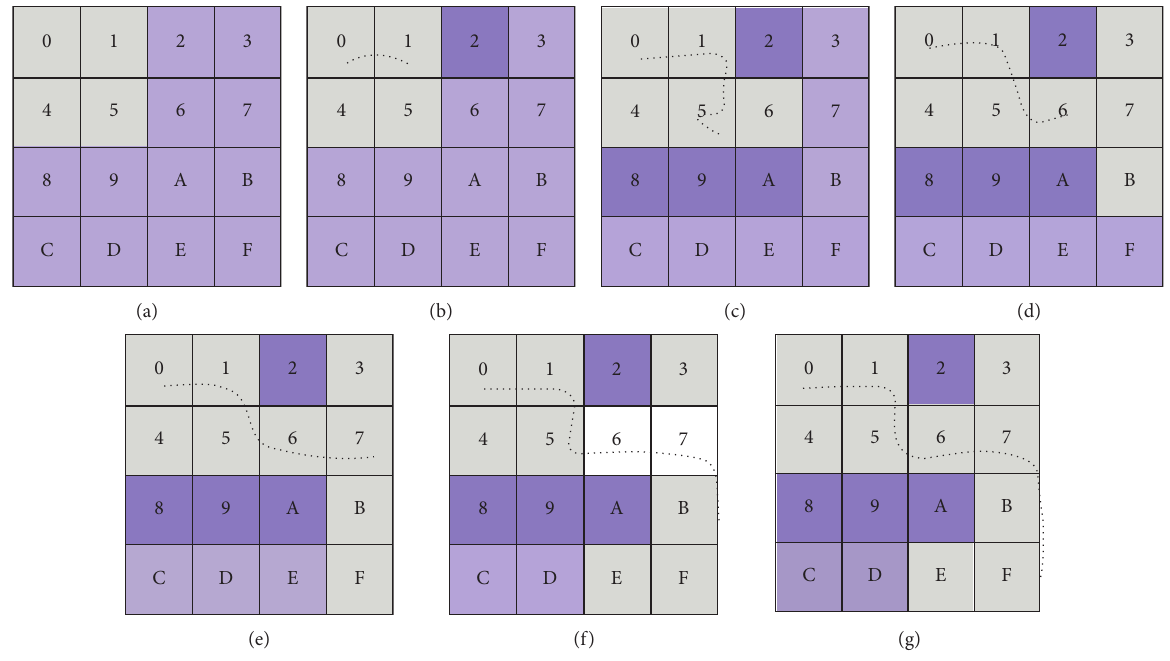
Figure 2: An example diagram of the path planning algorithm flow. (a) Initial path planning. (b) The first step of path planning. (c) The second step of path planning. (d) The third step of path planning. (e) The fourth step of path planning. (f) The fifth step of path planning. (g) Path planning completed.